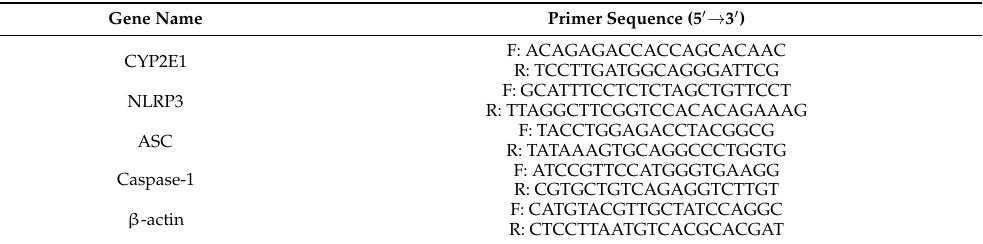
Table 1. Human primer sequences for